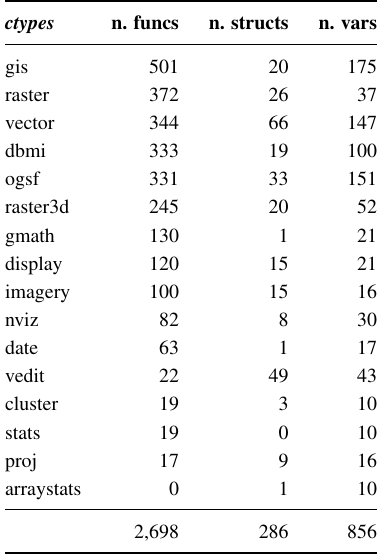
Table 1. GRASS C API consists of 2,698 C functions that are available through the ctypes library, divided into 10 different fields. This data is derived from the official GRASS source code.